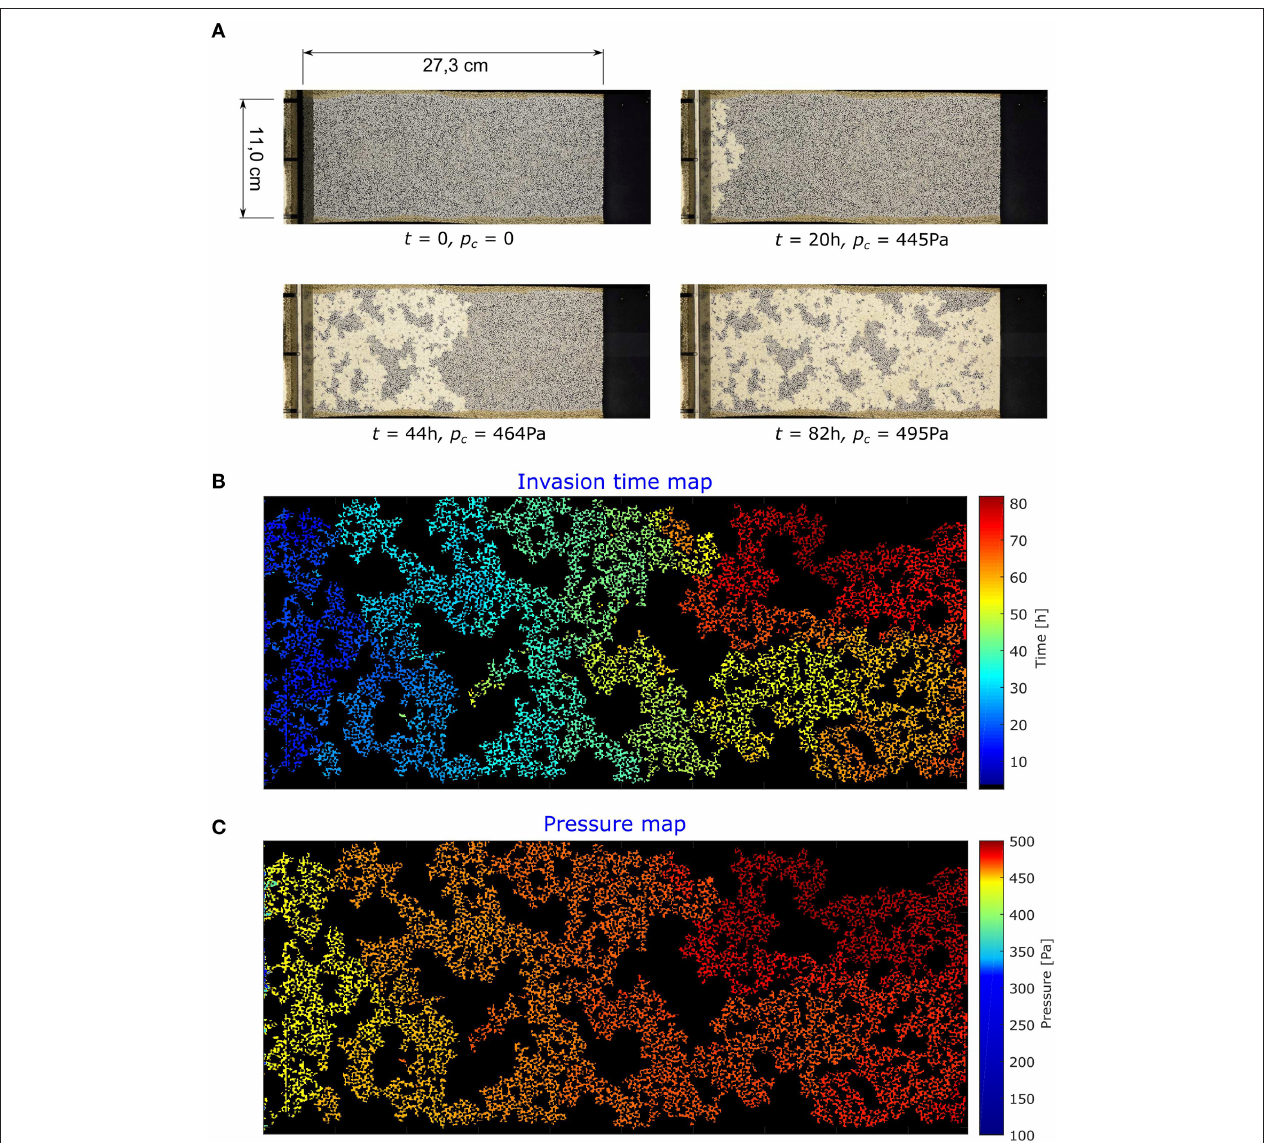
FIGURE 3 | (A) Images from the drainage process driven by the CIP boundary condition. The time t of each image is shown in hours and the instantaneous capillary pressure p c in Pascal. The porous medium is initially saturated with the liquid phase (blue) which is then gradually displaced by the invading air phase (white). On (B) we show a spatiotemporal map of the invasion, the color code indicating the invasion time of a given pore. On (C) we show the imposed pressure map, in which the color code denotes the imposed pressure (given by the height of the external reservoir), at which the invasion of a given pore